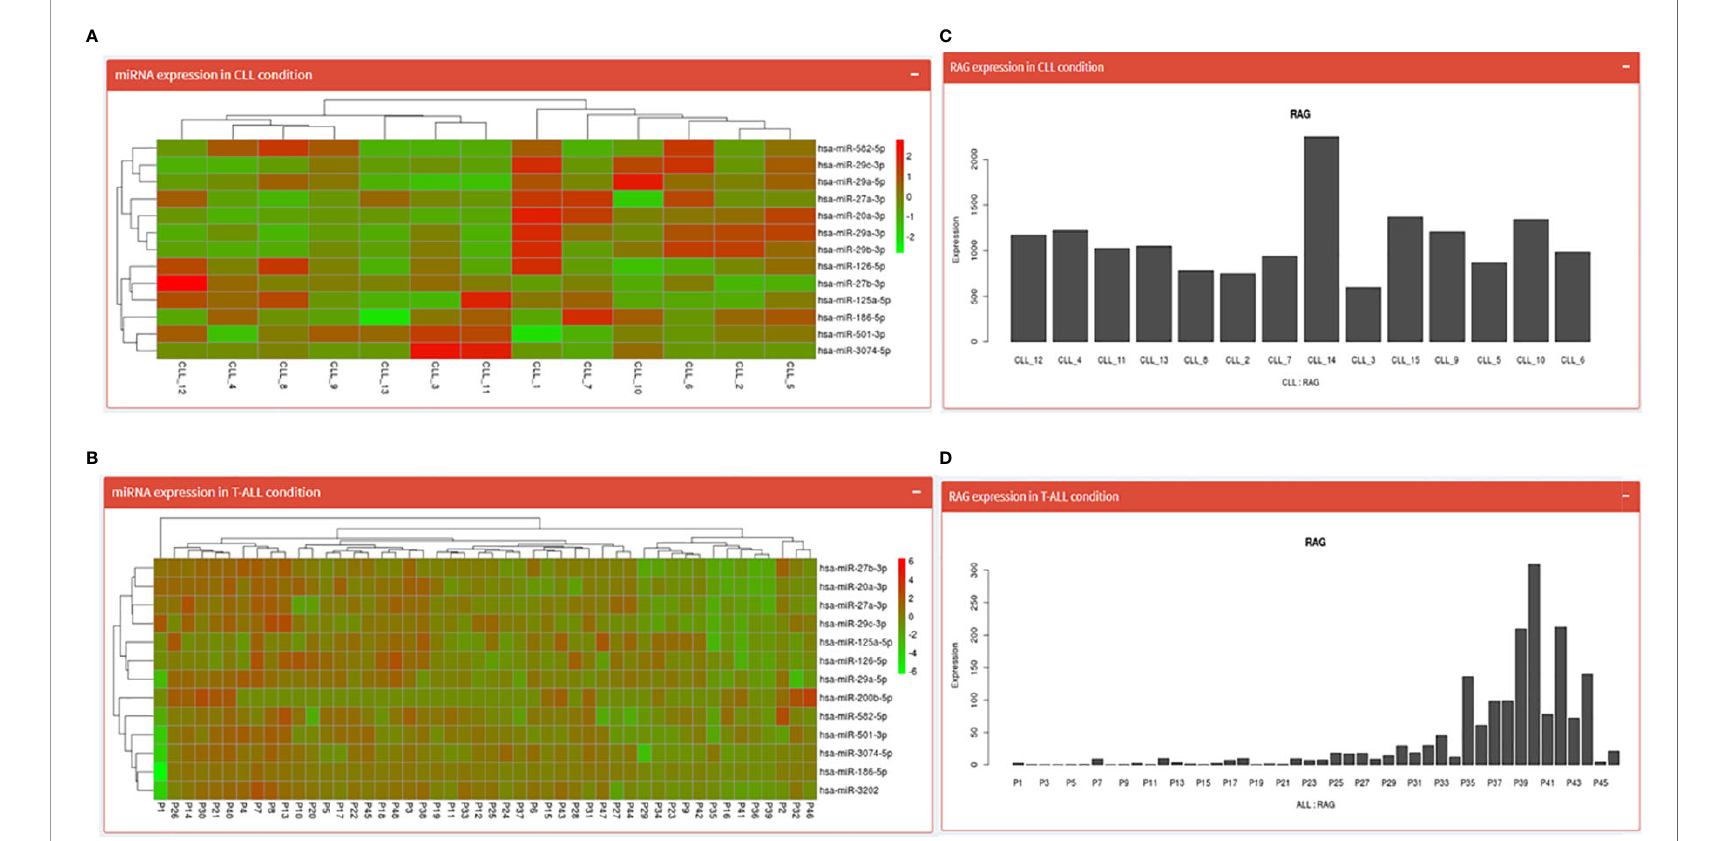
FIGURE 4 | CLL and T-ALL pages; where (A, B) show the heatmaps of miRNA regulating RAG1 in CLL and T-ALL conditions while (C, D) depict normalized RAG1 expression values in these